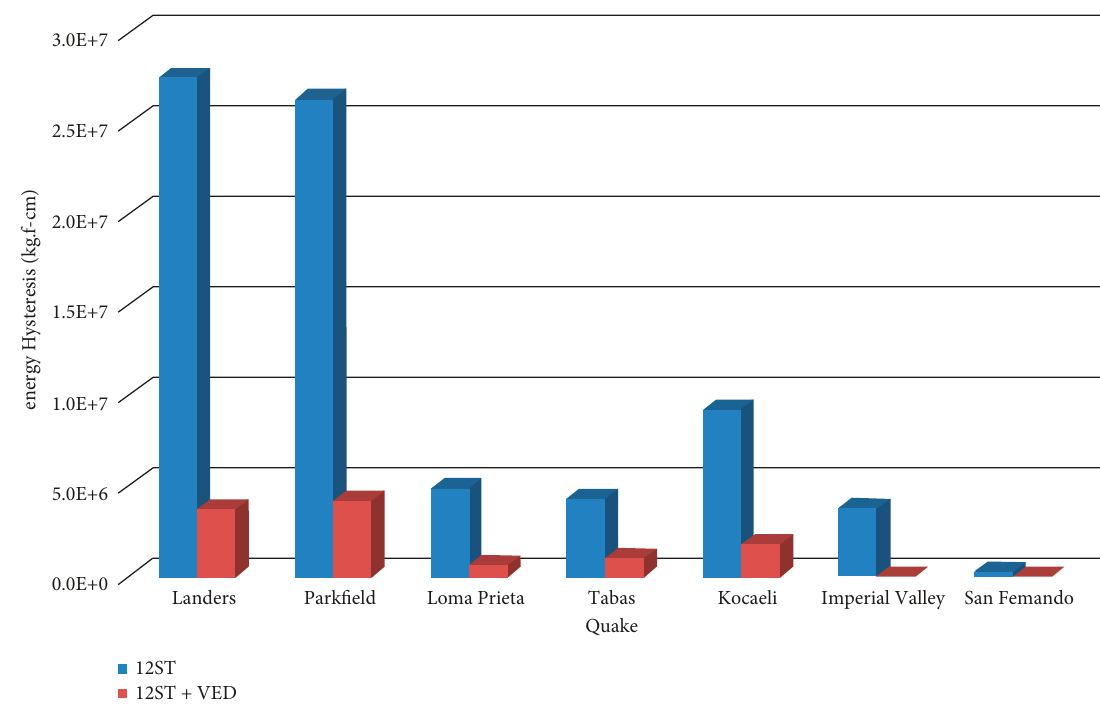
Figure 11: Hysteresis energy applied to the 12-floor frame under near-field records, in two modes with and without